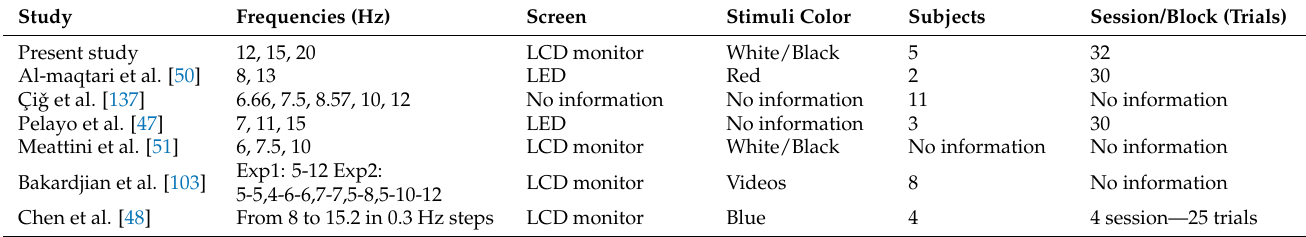
Table 9. Stimuli